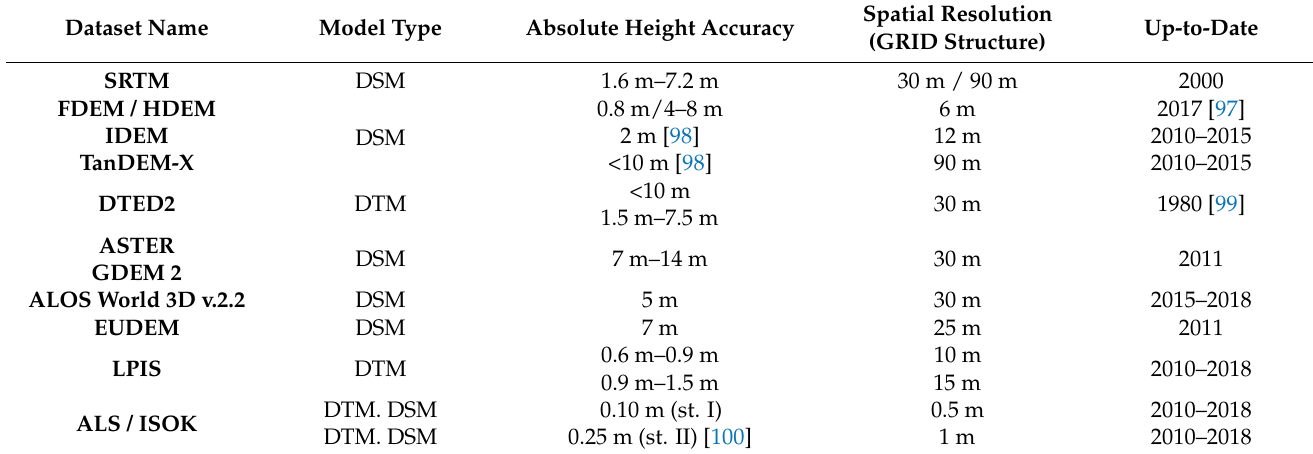
Table 2. Summary of the commonly used elevation data for the area of Poland. DTM: digital terrain model and DSM: digital surface